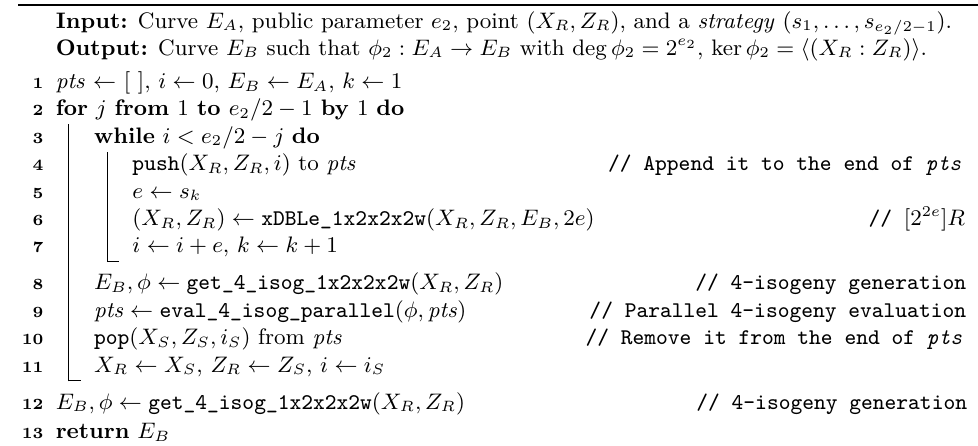
in SIKEp503 using the optimal 2